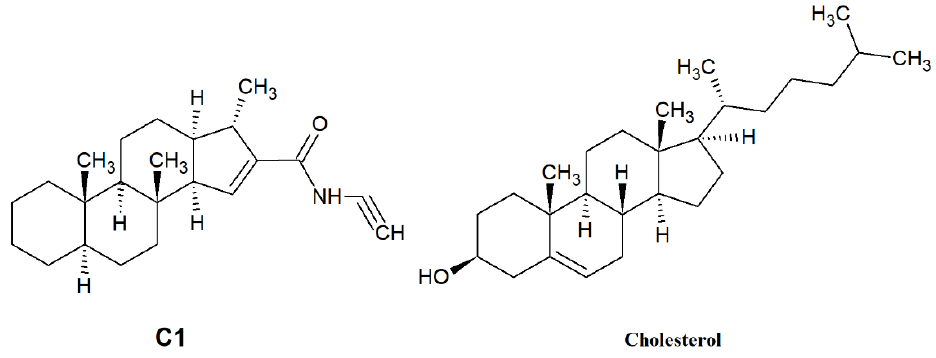
Figure 5. Structure of C1 compound and cholesterol.